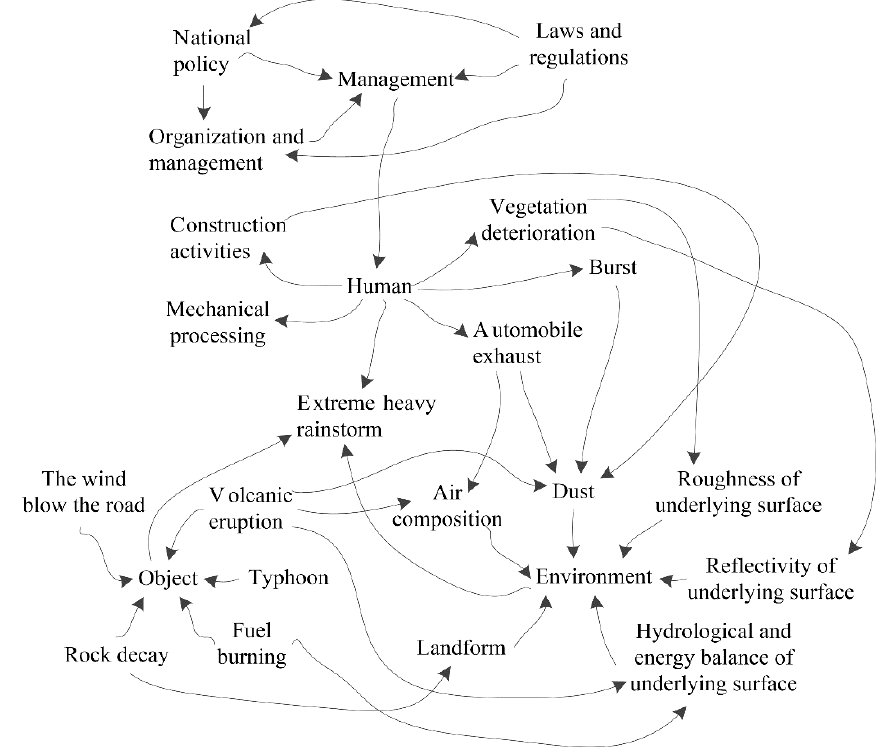
Figure 7. The butterfly effect in the evolution process of an extremely heavy rainstorm.